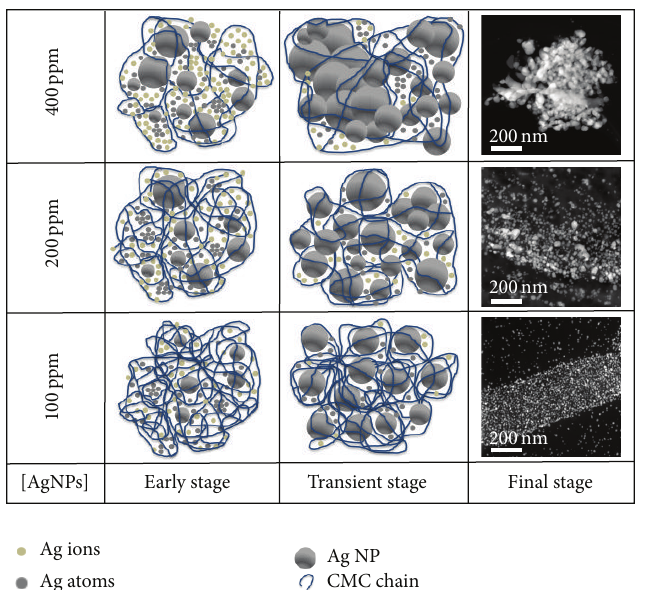
Figure 5: Schematic that represents the proposed mechanism for the synthesis of AgNPs, in which the CMC acts as stabilizer and reducing